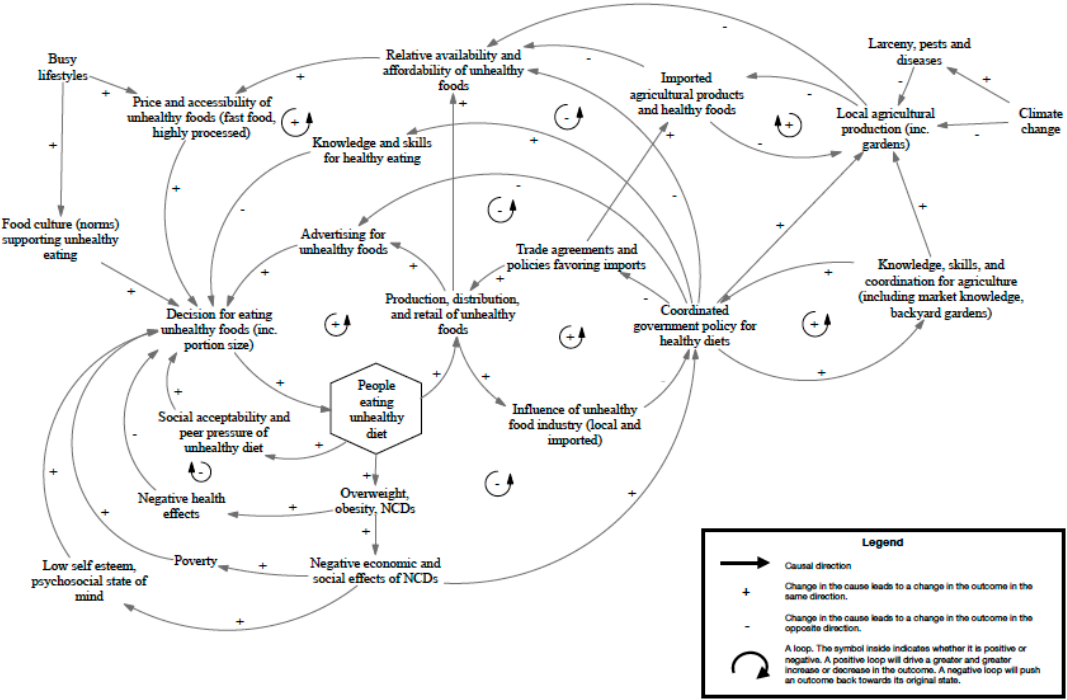
Figure 3. Causal map of unhealthy diet generated from group model building for St. Kitts and Nevis and St. Vincent and the Grenadines.